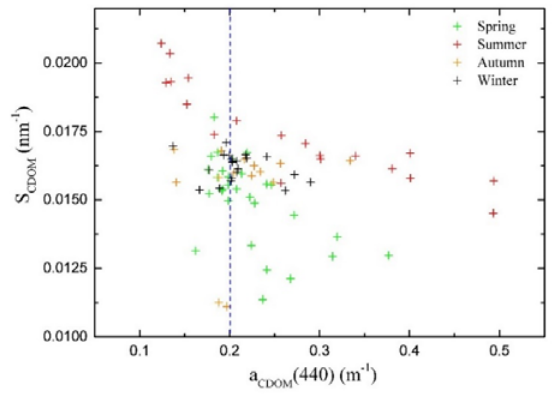
Figure 9. Scatterplot of (440)